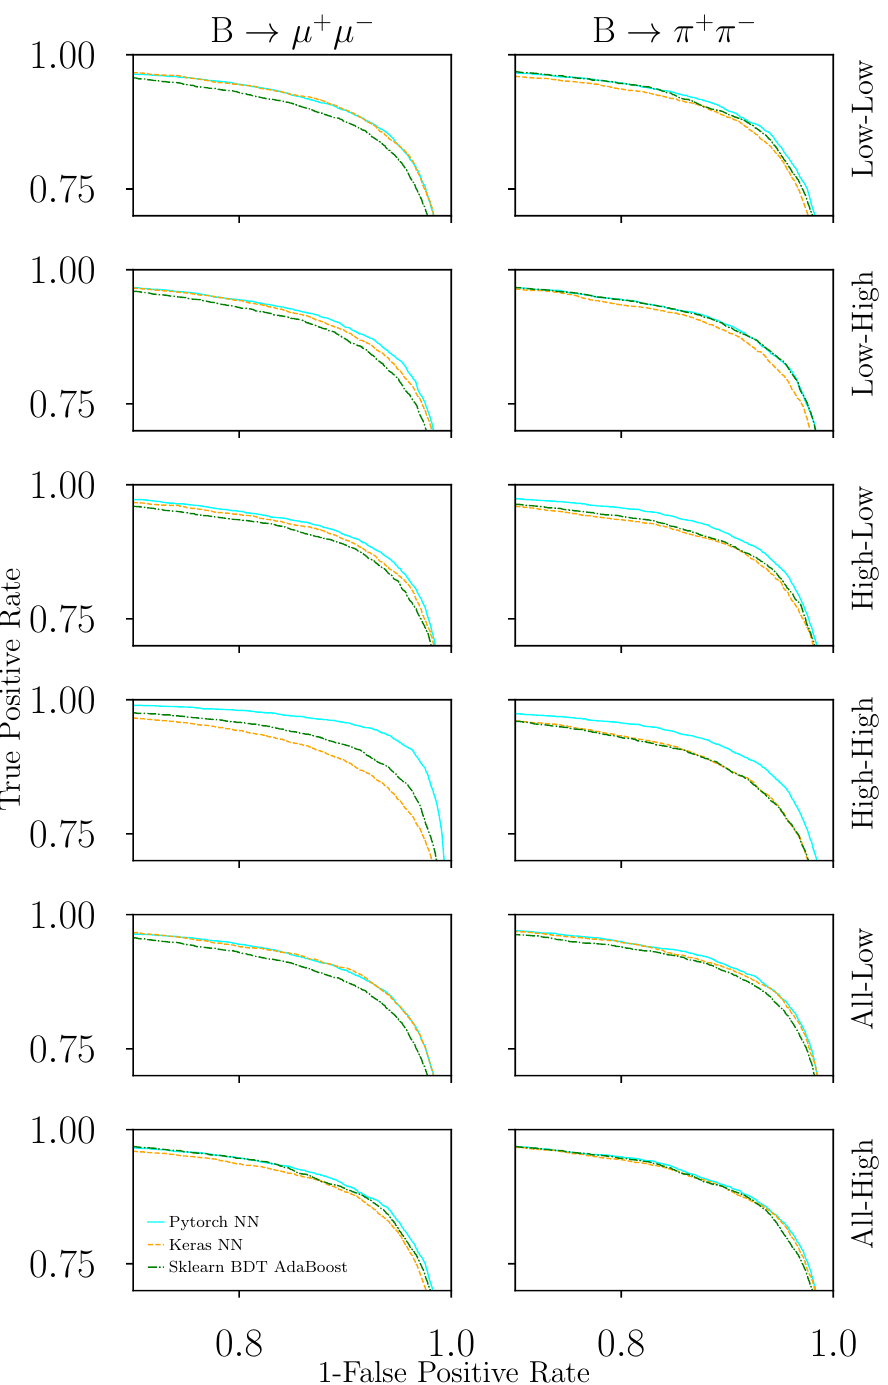
Figure 6. ROC Curve for the B training. The options are those listed in Section